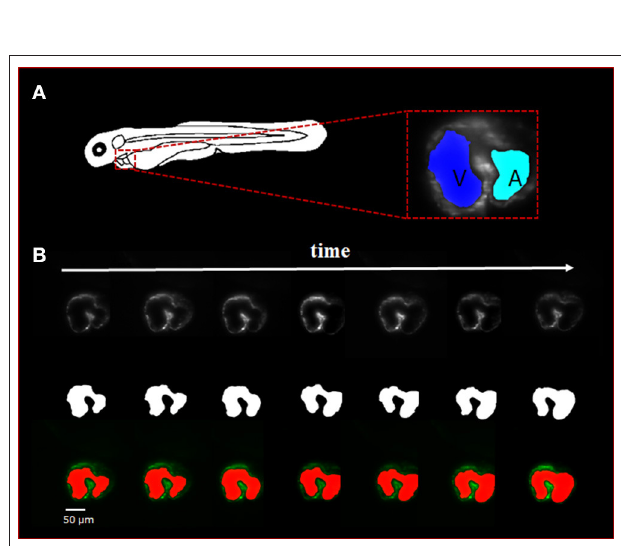
FIGURE 2 | Sequence of selected light-sheet fluorescent microscopy (LSFM) images with the manual hand segmentation mask from 4 dpf zebrafish heart. (A) Diagram showing the anatomical feature of the zebrafish heart as well as a single axial slice with corresponding binary mask generated by the U-net. It is observed that there is a clear distinction between the atria and ventricle of the specimen. (B) A sequence of selected axial slices with corresponding binary masks generated by our U-net program; the reference scale bar is 50 µ